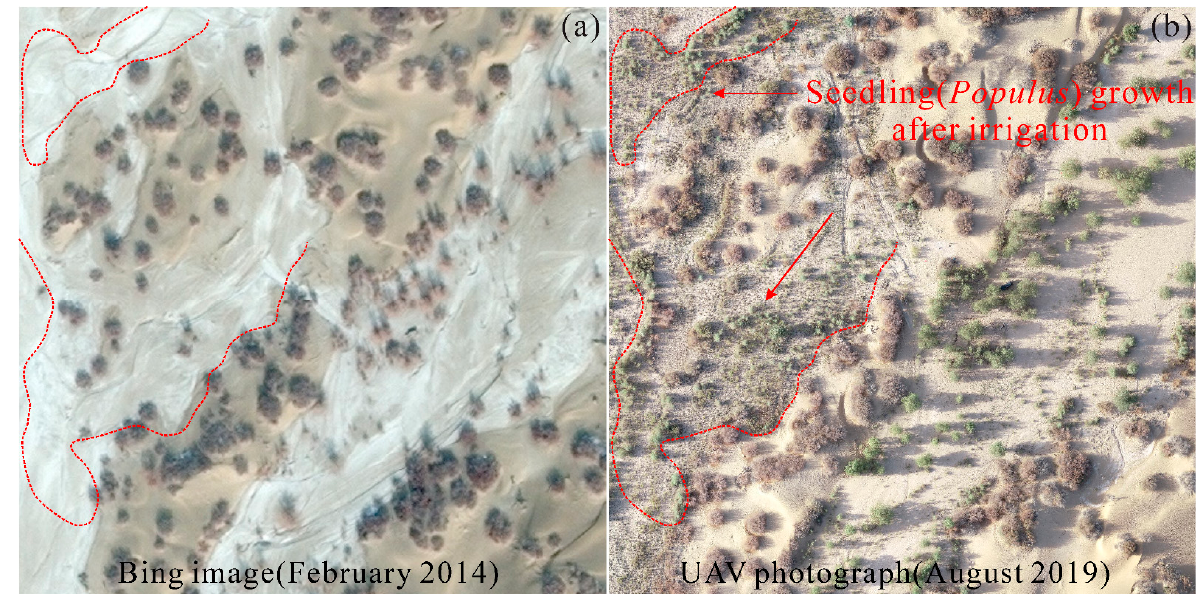
Figure 12. ( a ) Bing image captured on February 2014; ( b ) UAV aerial photograph captured in August 2019, showing the growth of Populus seedlings after flood events that inundated the floodplain. In addition, we estimated the annual amount of ecological water diversion (river wa- ter) that discharged into the Daliyaboyi Oasis. In particular, the average annual runoff in the headwaters of this catchment is 7.58 × 10 8 m 3 , and the average annual water consump- tion in the midstream agricultural oasis is 4.76 × 10 8 m 3 (obtained from the Yutian Water Conservancy Bureau of Xinjiang Uygur Autonomous Region, China). Given the effect of river water leakage (infiltration) and groundwater recharge [38], the annual amount of water that flows into the Daliyaboyi Oasis, and can be used for ecological diversions, should be about 2 × 10 8 m 3 [40].